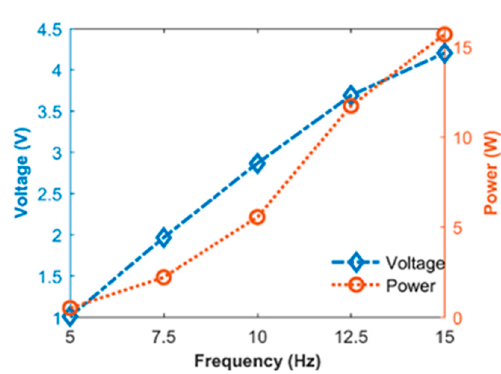
Figure 10. The voltage and power versus frequency.